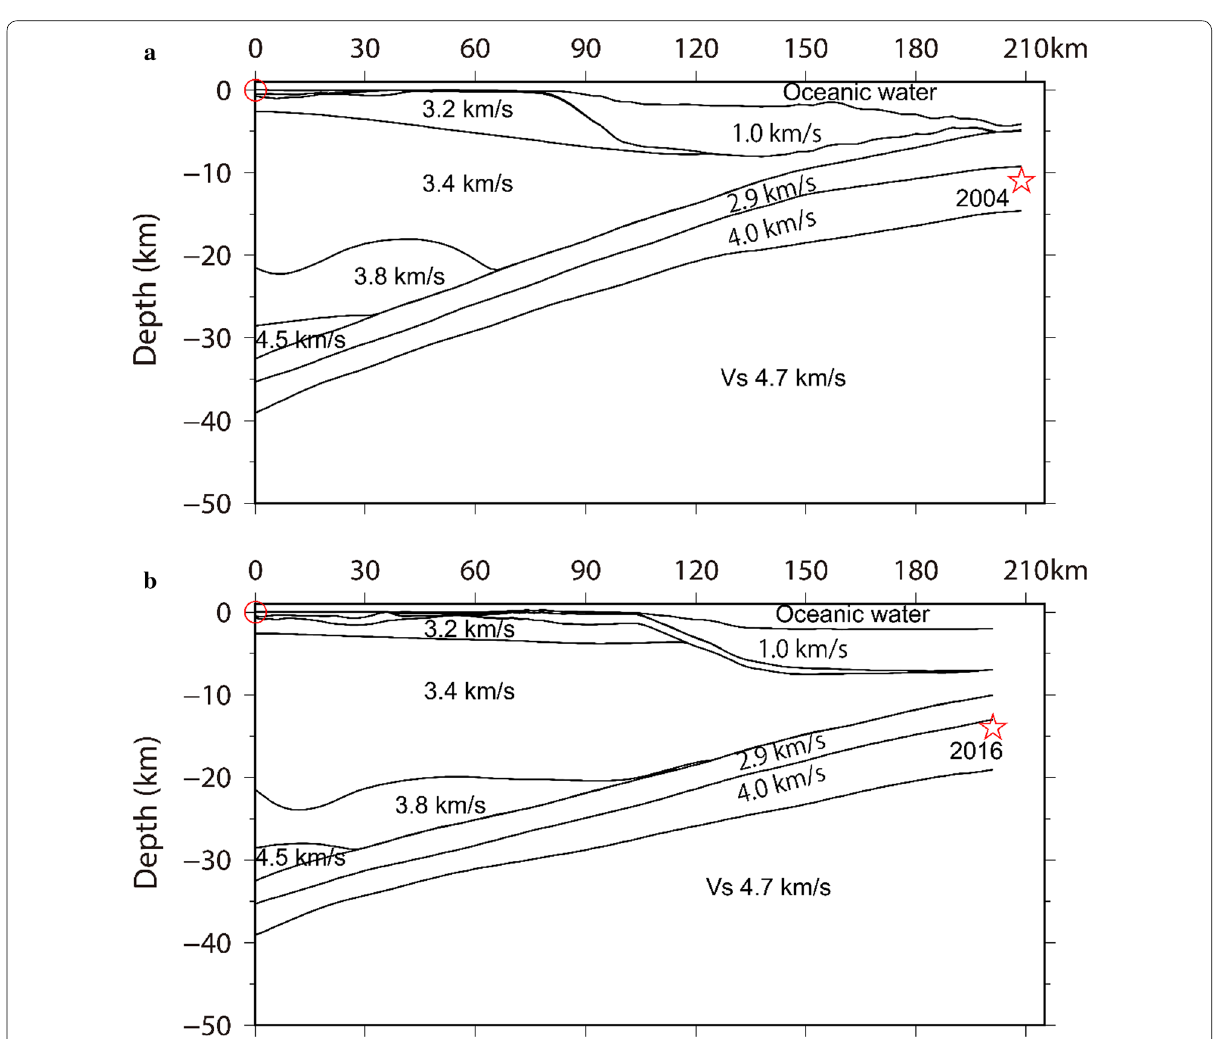
Fig. 2 a , b Vertical cross sections of the JIVSM along the surface lines joining site AIC004 with the epicenters of the 2004 and 2016 events, respectively. The S-wave velocities in major layers are indicated. The circles and stars denote the location of site AIC004 and the F-net centroid depths of the events, respectively. Note that the vertical and horizontal scales are